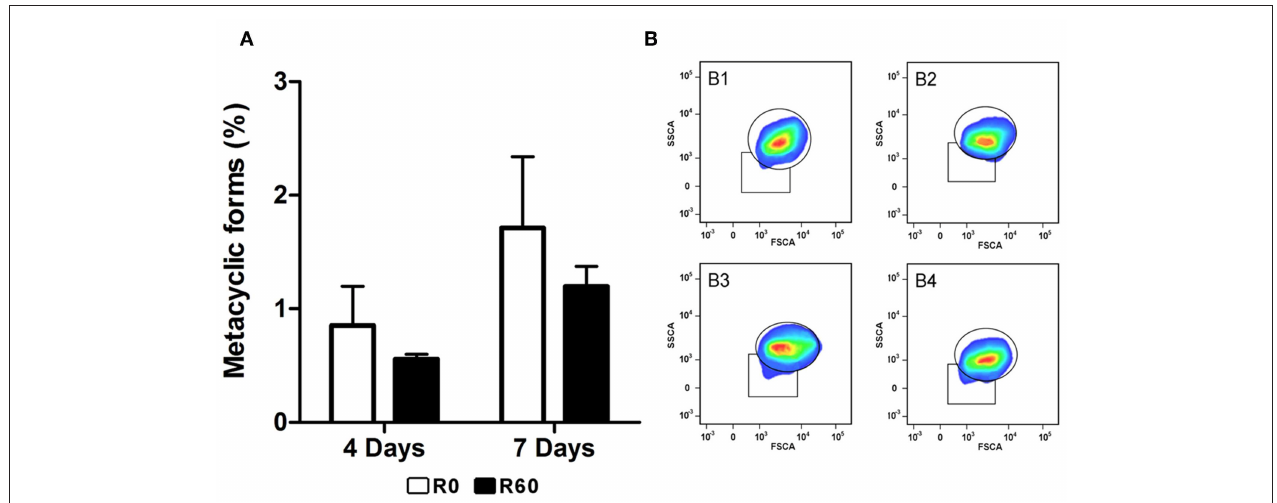
FIGURE 2 | Evaluation of metacyclogenesis in R0 and R60 cell lines. Promastigotes from R0 and R60 cell lines were cultivated in M199 medium (10% BFS, 26 ◦ C). R0 and R60 cultures at late log (4th day of growth) and stationary phases (7th day of growth) were analyzed by flow cytometry using BD Fortessa. (A) Percentages of promastigote metacyclic forms in R0 and R60 cell lines in late log (4 days) and stationary (7 days) phases. (B) B1 and B2 represent, respectively, R0 and R60 at the 4th day of growth. B3 and B4 represent, respectively, R0 and R60 at the 7th day of growth. The bars represent the average of two assays, minus and plus the standard deviation, in two independent analyses. Significant differences were investigated by Two-Way ANOVA.